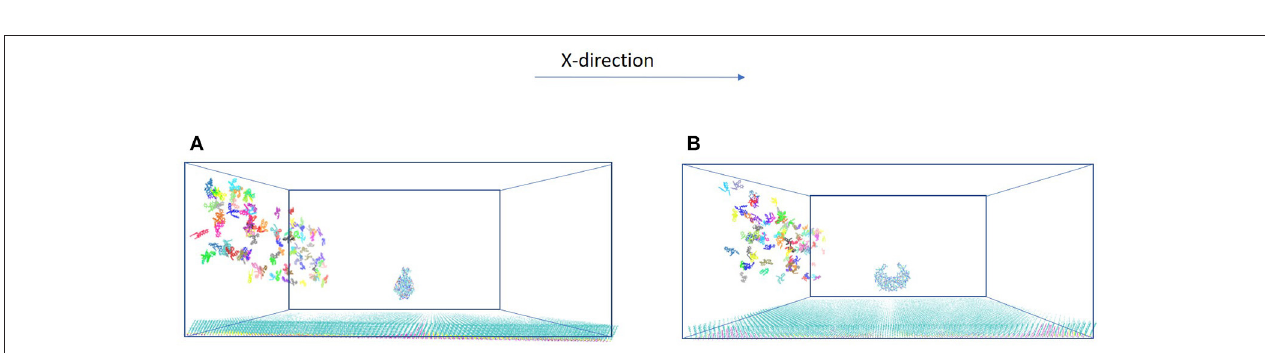
FIGURE 2 | Two orientations of HIVp. The protein is placed 20 Å above the SAM (A) parallel to the yz-plane and (B) perpendicular to the yz-plane.